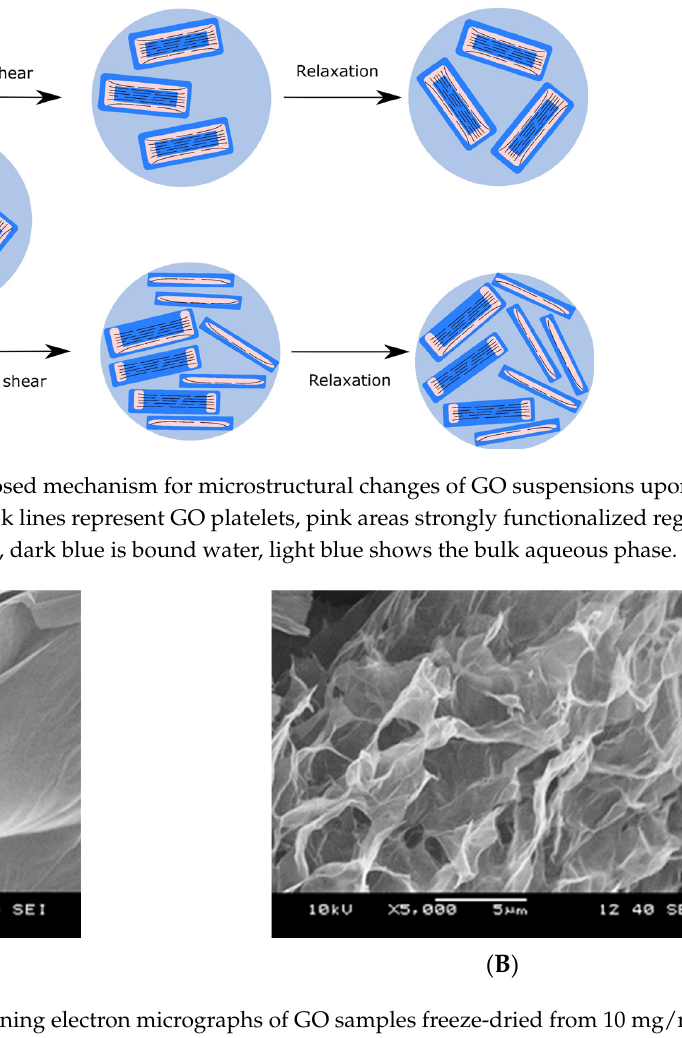
Table 2. XRD characteristics of freeze-dried graphene oxide before and after shearing